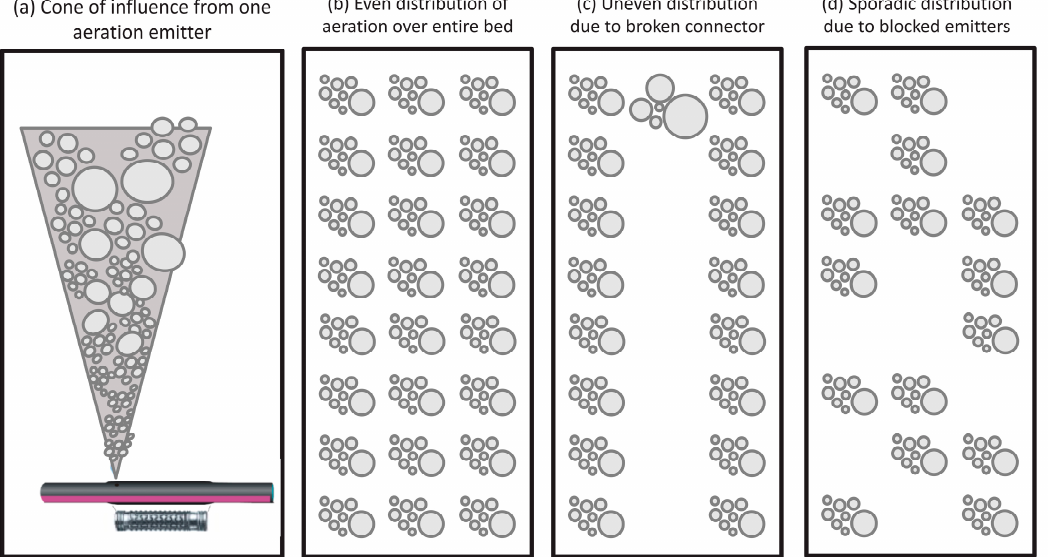
Figure 5. Blocked emitter orifices from an aerated wetland treating landfill leachate.